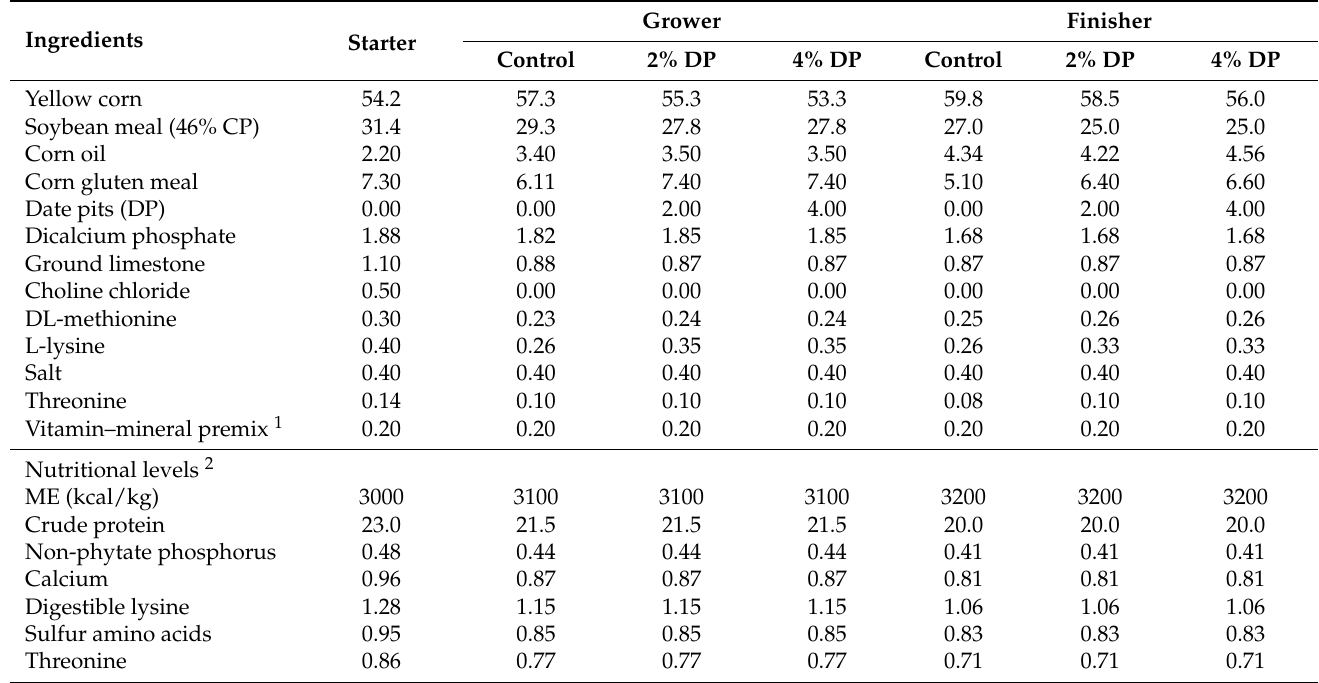
Table 1. Formulation of the starter (1–10 d), grower (11–20 d), and finisher (21–30 d) experimental diets (%, as-fed